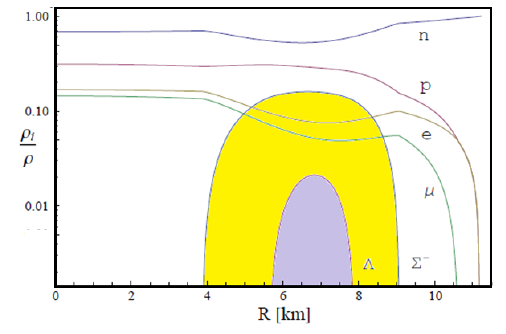
Figure 5. (Color online) Density dependence of in-medium hyperon-nucleon interactions in symmetric nuclear matter. OBE-results scattering length in the S = -1 channels are shown as a function of the Fermi-momentum of the background medium. Λ n belongs to the charge-neutral triplet and is cou- pled to the Σ 0 n and the Σ − p channels.